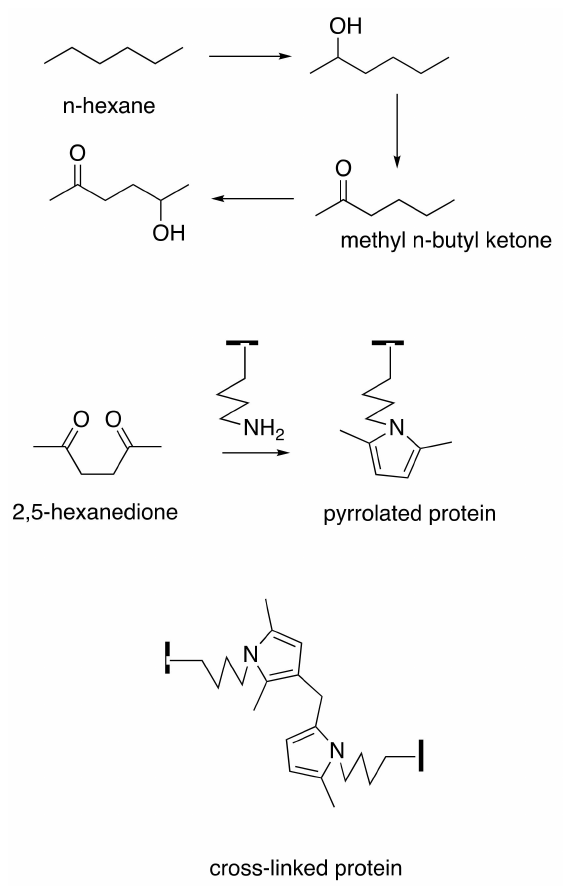
Figure 3. The C6 solvents n -hexane and methyl n -butyl ketone (2-hexanone) are converted by ω -1 hydroxylation and oxidation to 2,5-hexanedione, which reacts with lysyl ε -amines of pro- teins to form pyrrolated proteins that undergo intra- and intermolecular cross-linking reactions, including dimer formation. Redrawn from Boekelheide, K.; Fleming, S.L.; Allio, T.; Embree-